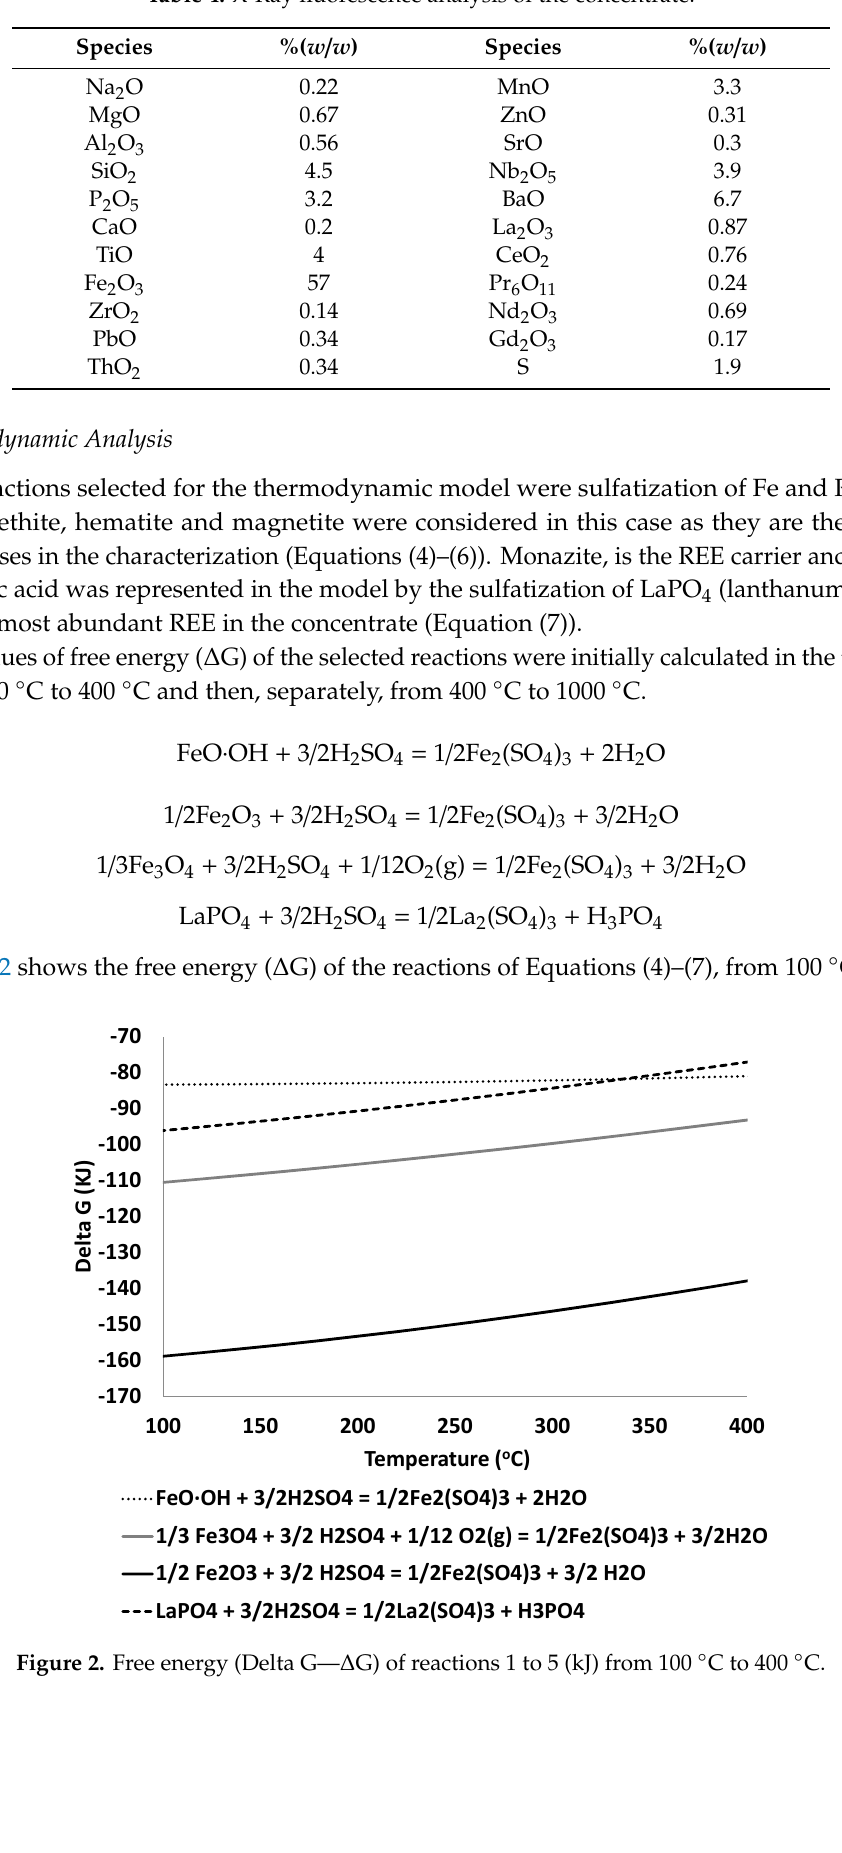
Table 4. X-Ray fluorescence analysis of the concentrate.